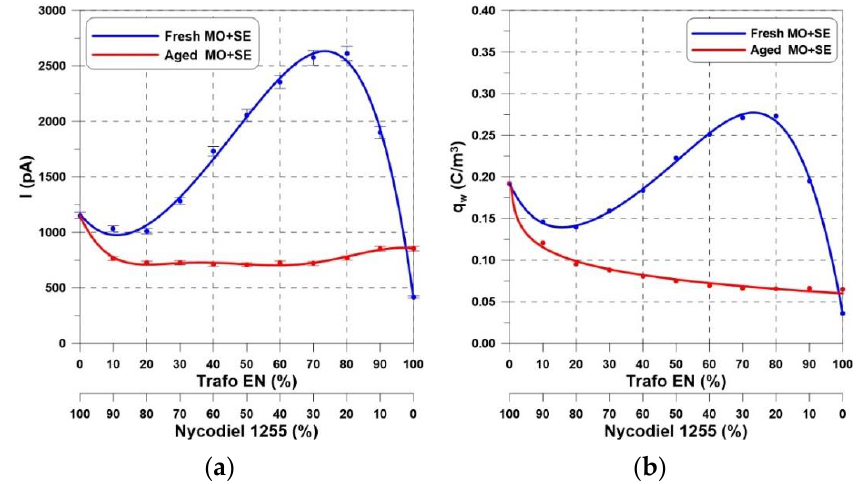
Figure 6. ( a ) Electrification current and ( b ) volume charge density q w vs. mixing of Nycodiel 1255 synthetic ester with fresh and aged Trafo EN mineral oil ( v = 500 rpm, d = 80 mm).